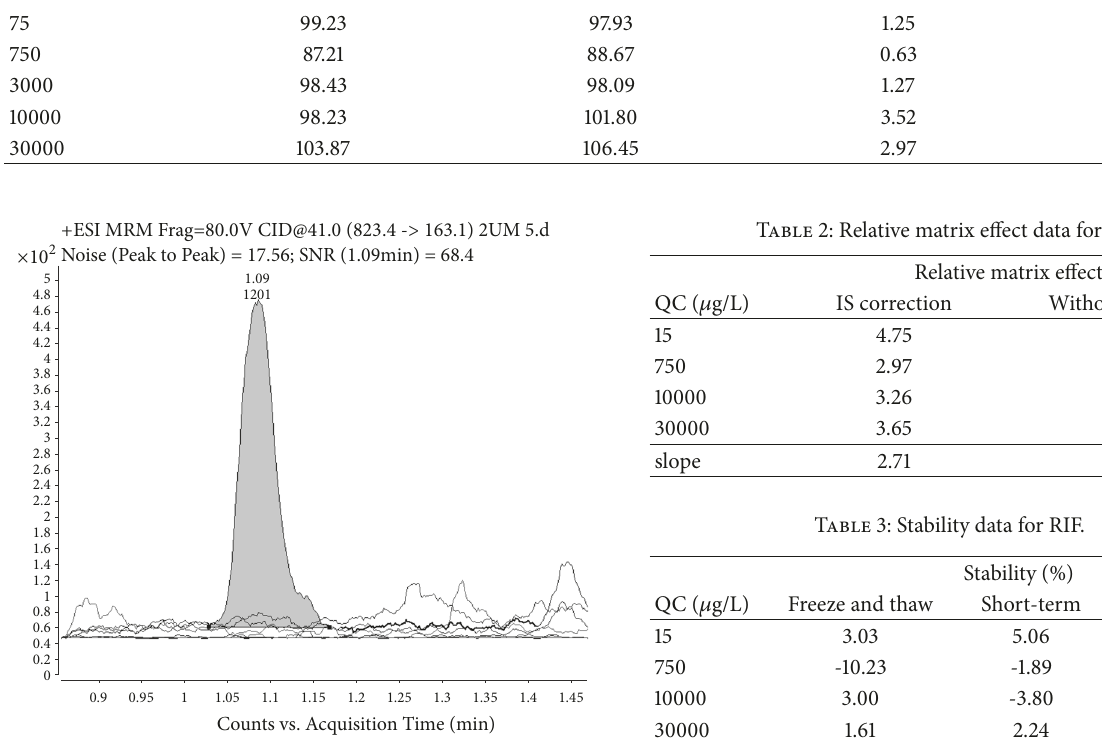
Figure 1: Representative LC-MS/MS chromatograms of six blank plasma samples and LLOQ sample. Retention time of RIF is 1.1 min.